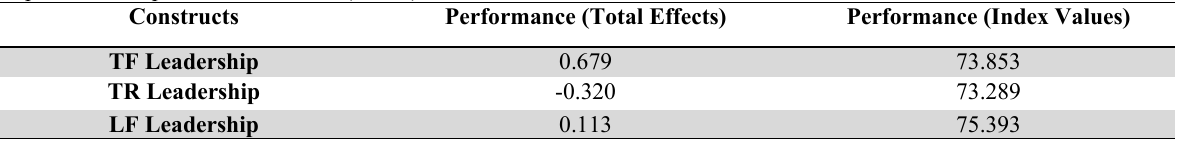
Importance and performance matrix (IPMA)